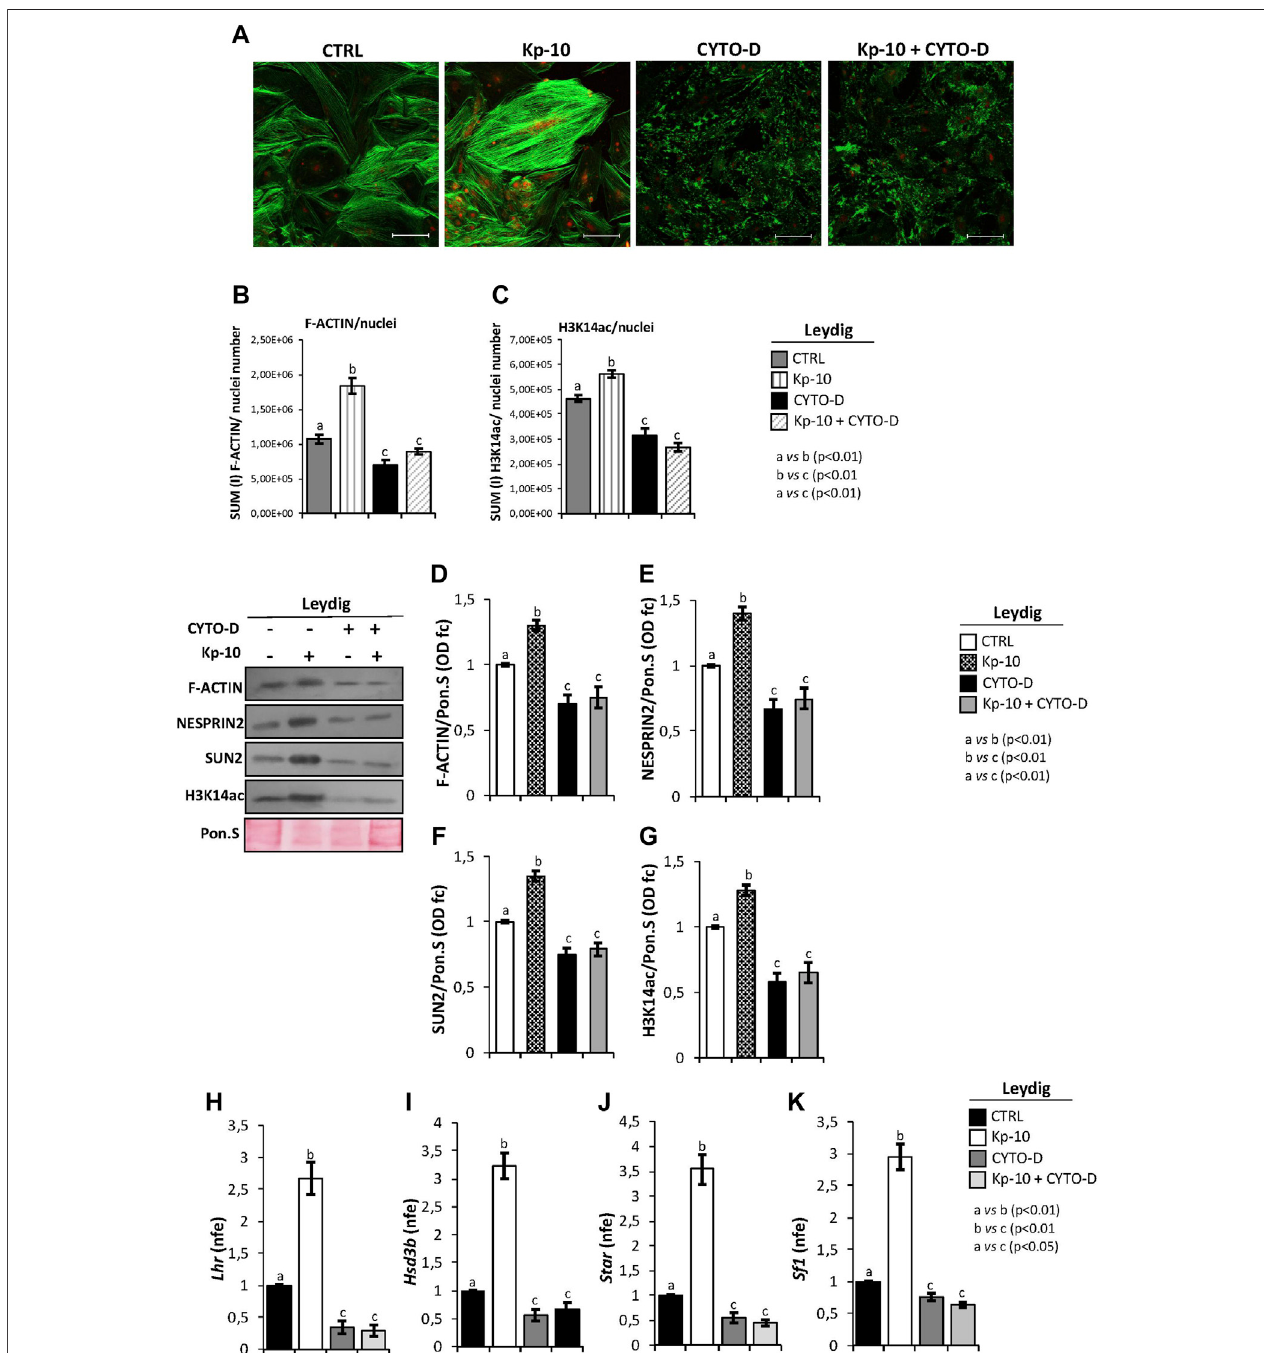
FIGURE 5 | (A) Immuno fl uorescence analysis of F-actin (green) and H3K14ac (red) in murine primary Leydig cells in vitro treated with Kp-10 (0.1 µM) and cytochalasin D (CYTO-D) (10 µM) alone or in combination with Kp-10 (Kp-10+CYTO-D). Nuclei were labeled with TO-PRO3 iodide (blue). Scale bar: 37.5 µm. (B,C) Quantitative immuno fl uorescence analysis of F-actin and H3K14ac signals. Data were normalized against nuclei number, expressed in SUM(I) values and reported as mean ± SEM; experimental groups with statistically signi fi cant differences ( p < 0.01) were indicated with different letters; the experimental groups without statistically signi fi cant differences were indicated with the same letter. Western blot analysis of (D) F-actin, (E) NESPRIN2, (F) SUN2, and (G) H3K14ac proteins levels in murine primary Leydig cells in vitro treated with Kp-10 (0.1 µM) and cytochalasin D (CYTO-D) (10 µM) alone or in combination with Kp-10 (Kp-10 + CYTO-D). Signals were quanti fi ed by the densitometry analysis and normalized to Ponceau Red (Pon.S). Data are expressed in O.D. values as fold change (O.D. fc), relatively to the CTRL group,andreportedasmean±SEM;experimentalgroupswithstatisticallysigni fi cantdifferences( p < 0.01)wereindicatedwithdifferentletters;theexperimental groups without statistically signi fi cant differences were indicated with the same letter. The differential expression analysis of Leydig cell genes in primary Leydig cells in vitro